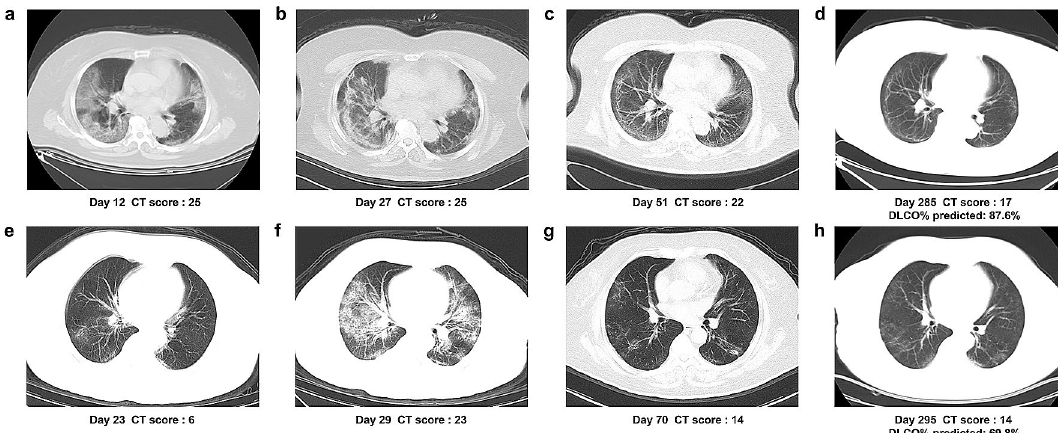
Figure 1. Serial HRCTs of two severe COVID-19 with different pulmonary diffusion function status. ( a – d ) Serial HRCTs of a 65-year-old COVID-19 female patient with normal pulmonary diffusion function at eight months post discharge: ( e – h ) Serial HRCTs of a 71-year-old COVID-19 female patient with abnormal pulmonary diffusion function at eight months post discharge.